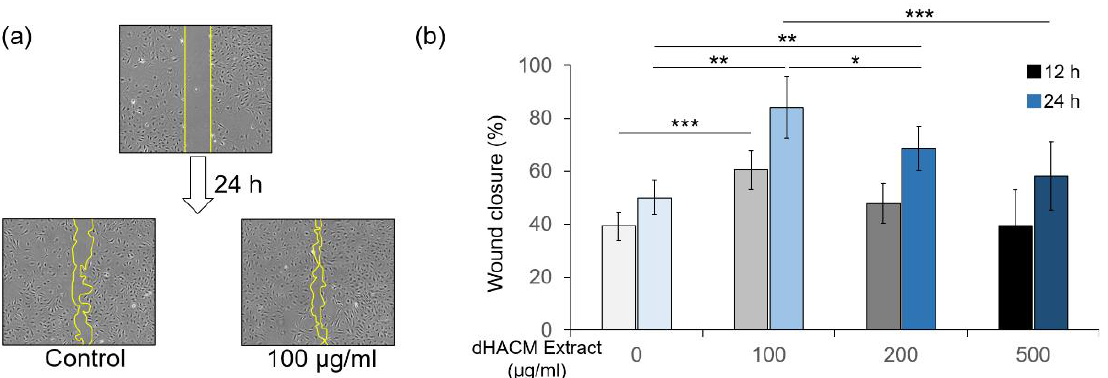
Figure 7. The effect of dHACM on cell migration. rPDLC monolayers were cultured to confluence, and various concentrations of dHACM extract were added and further incubated. Then multiple artificial wounds were made, and the wound area was monitored up to 12 and 24 h. Representative microphotographs of the wound closure after incubation with/without dHACM extract for 24 h ( a ). The rate of wound closure of rPDLCs treated with/without dHACM extract ( b ). This was obtained using the following formula: (initial wound area)—(wound area after an identified culture period)/(initial wound area) × 100. Values are shown as means ± standard deviations ( n = 9). * p < 0.05, ** p < 0.01, and *** p < 0.001, compared to the untreated control, ANOVA with Tukey post-test.